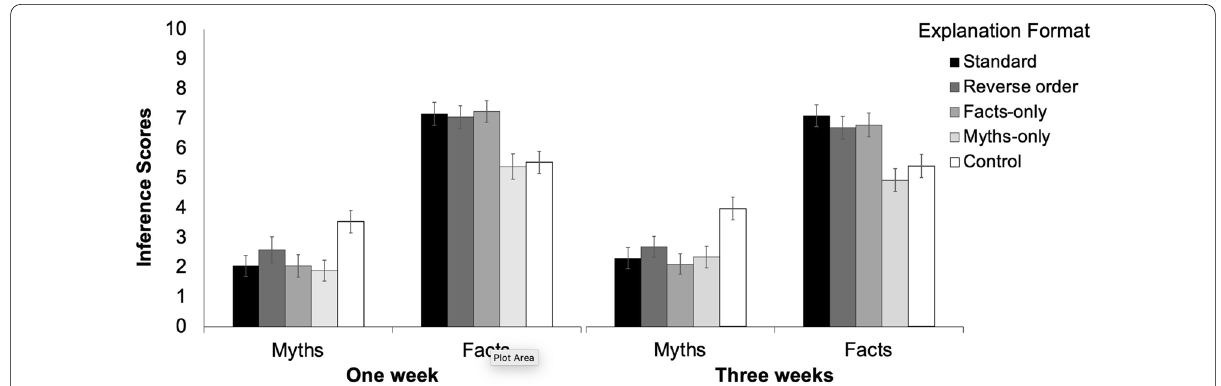
Fig. 5 Inference scores across conditions in Experiment 4. Error bars denote 95% confidence intervals